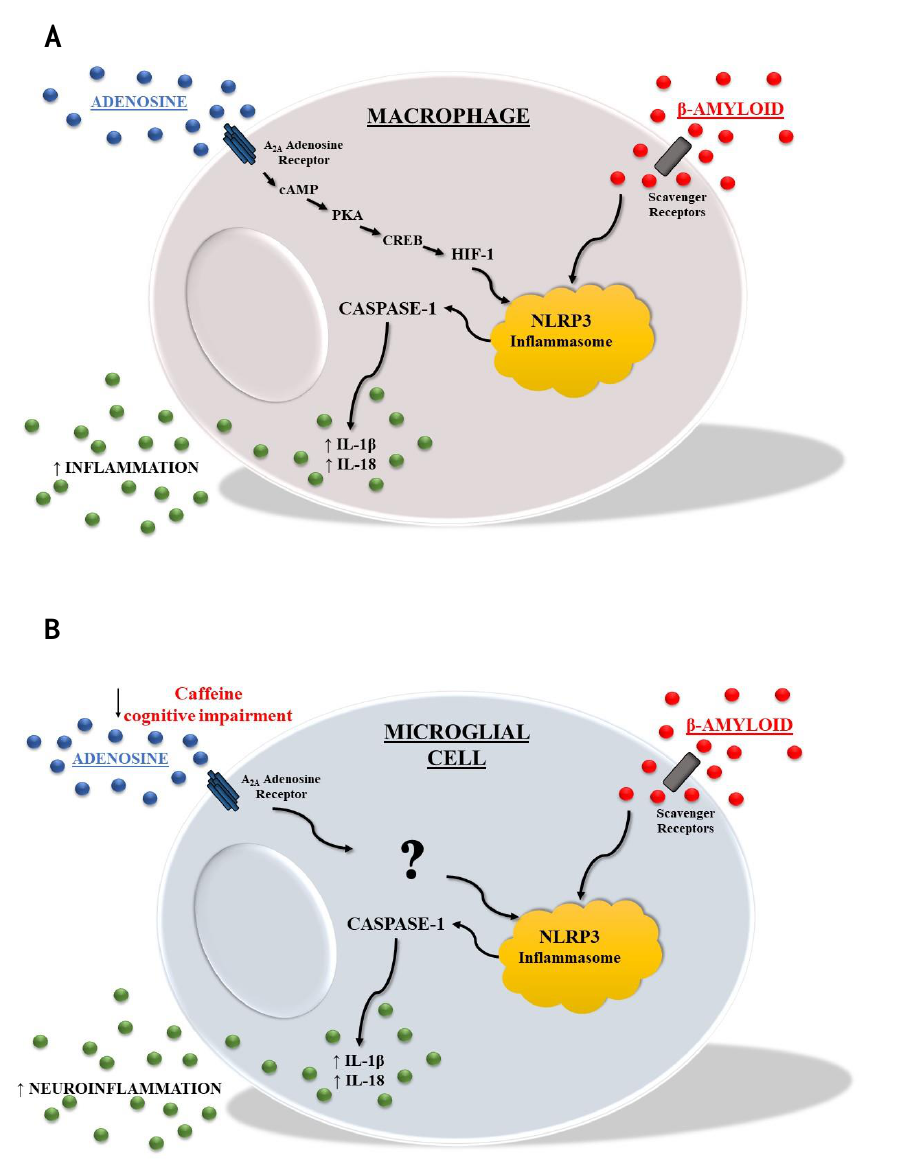
Figure 2. The picture represents the effect of A2A receptor activation on NLRP3 inflammasome function in macrophage ( A ) and microglia ( B ). ( A ) In macrophages, adenosine, increased during tissue injury, activates A2A receptor that through cAMP/PKA/CREB/HIF-1 α signaling results in upregulation of NLRP3, Caspase-1, and IL1 β /IL-18 production. ( B ) In microglia, adenosine, through A2A receptor, affects NLRP3 inflammasome and caffeine, and by blocking this signal may improve cognition. β -amyloid may engage the NLRP3 inflammasome, promoting production of proinflammatory